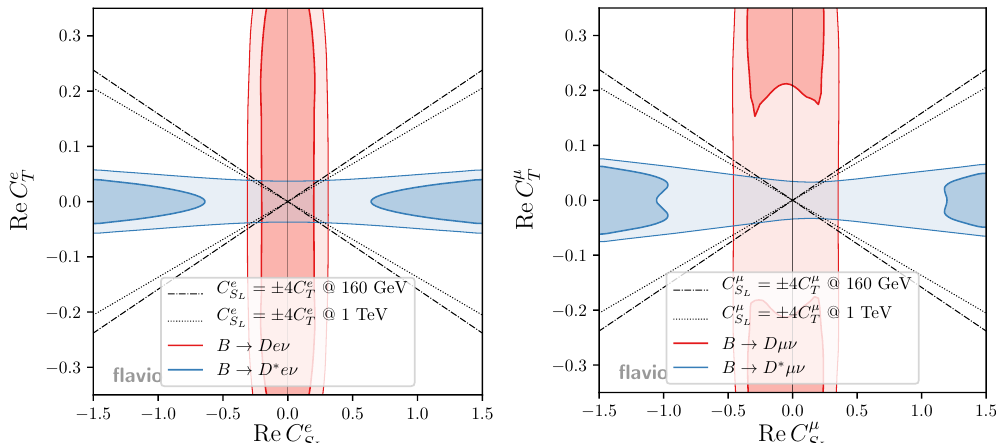
Figure 8 . Constraints on C e;(cid:22) vs. C e;(cid:22) , pro(cid:12)ling over V cb . The black dotted and dash-dotted lines S R T show the expected ratio of the Wilson coe(cid:14)cients in the two leptoquark scenarios S 1 and R 2